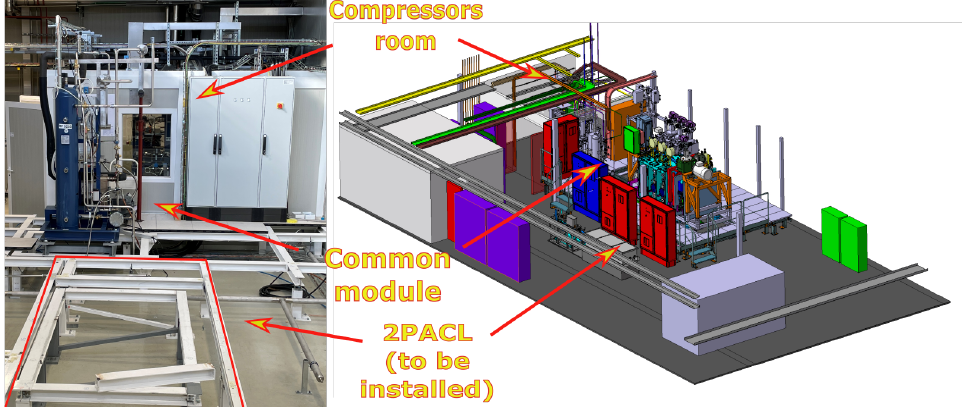
Figure 5. ( left ) Current installation with common equipment placed on the false floor and compressor units inside separate room ( right ) 3D model of final installation with the 2PACL system on place.